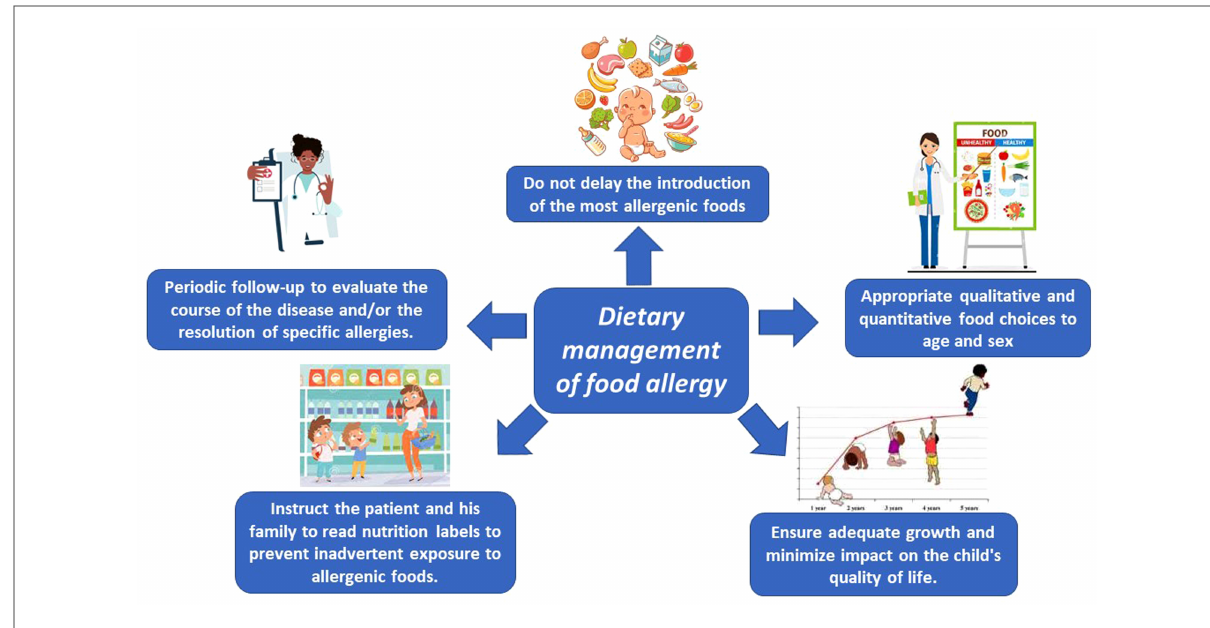
FIGURE 1 Factors to be considered in making a correct dietary management of food